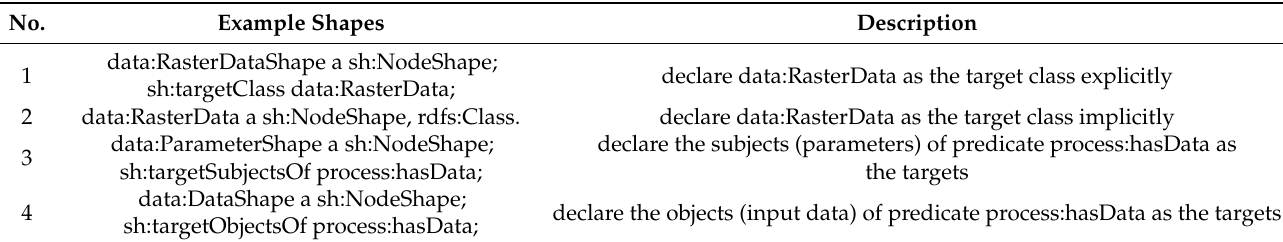
Table 4. Examples of class-level target declarations.